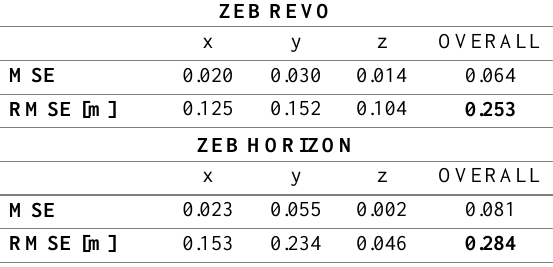
Table 4. Comparison of the errors of estimated positions The RMSE of estimated tree diameters by REVO